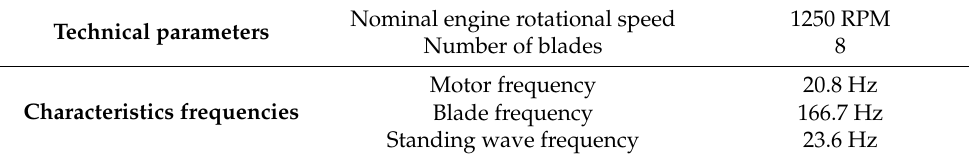
Table 1. Technical parameters and determined characteristic frequencies of the ventilation shaft. Technical parameters